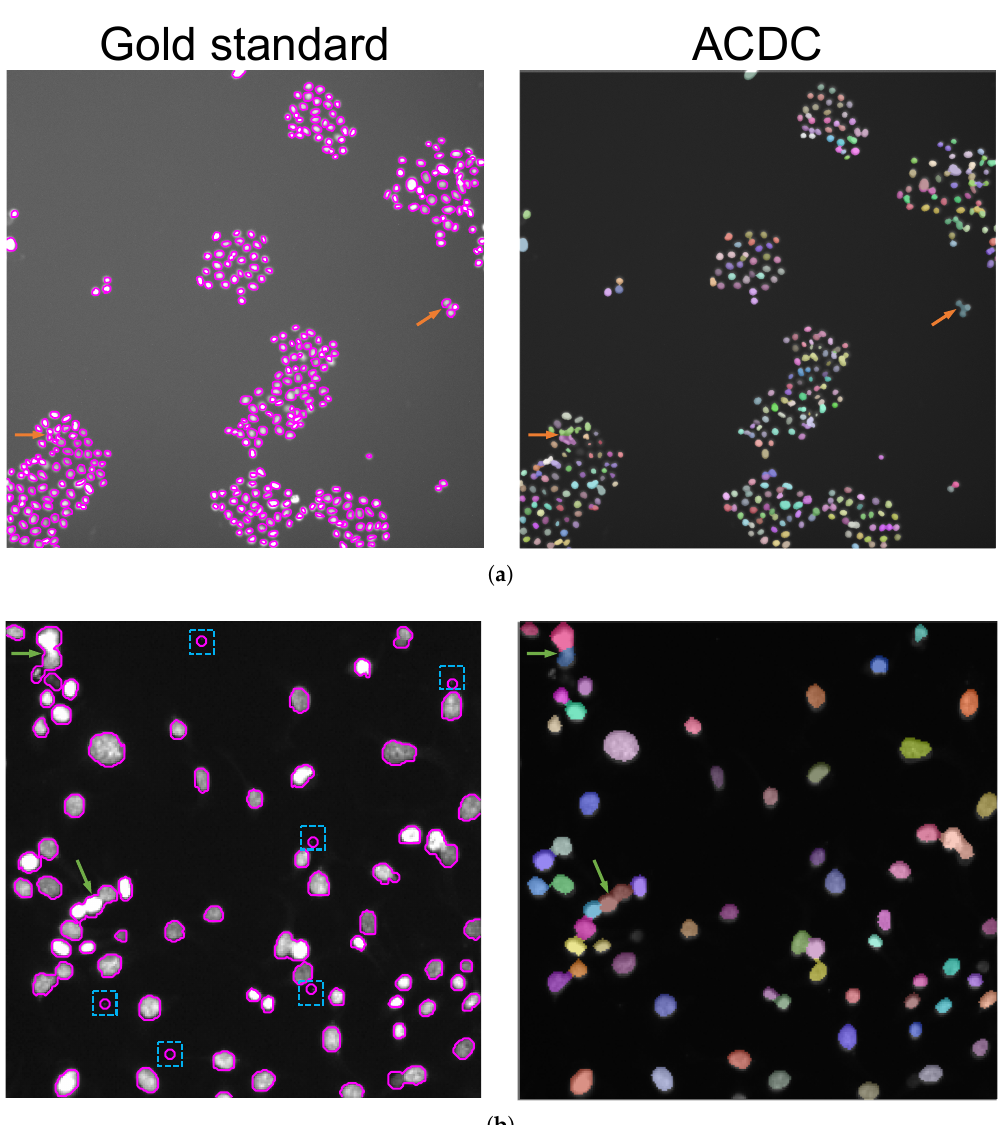
Figure 8. Comparison of the gold standard cell nuclei segmentation (magenta contour in the left images) against the automated result obtained by ACDC (segmented nuclei over-imposed onto the original fluorescence images with alpha-blending in the right images): ( a ) VU dataset, where the orange arrows denote errors in the split of clustered cell nuclei; ( b ) DSB dataset, where the green arrows denote groups of cells that were erroneously delineated as unique connected-components in the gold standard and the blue dashed boxes represent spurious speckles that are not detected by